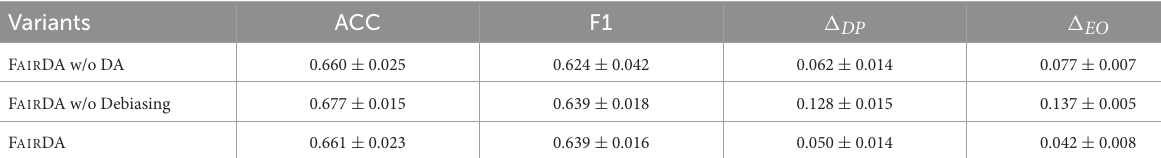
TABLE 5 Assessing the effectiveness of each component in F AIR DA.